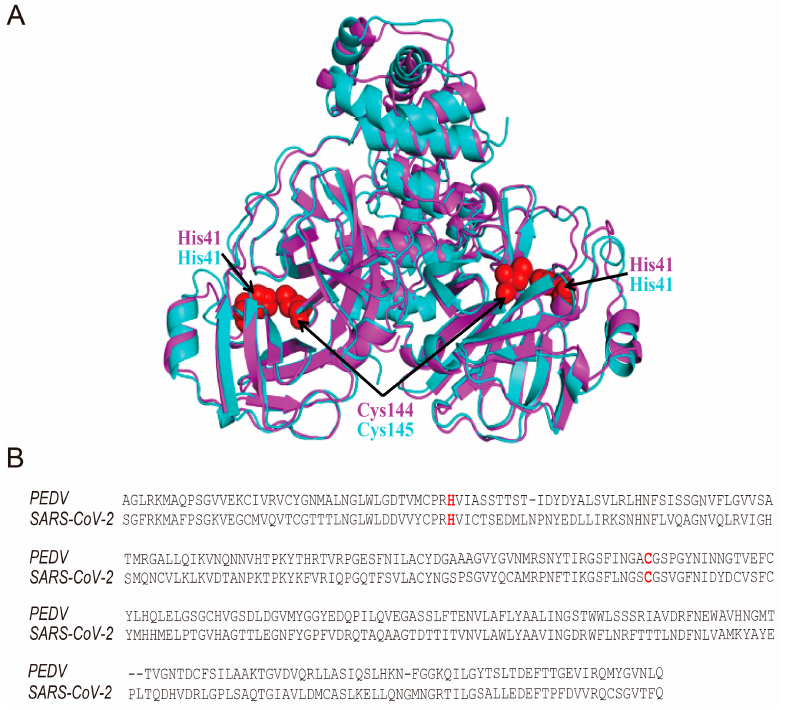
Figure 2. Alignments of PEDV and SARS-CoV-2 3CLpro in protein sequence and crystal structure. ( A ) The sequences of the PEDV 3CLpro (Accession number: MN644470.1) and SARS-CoV-2 3CLpro (Accession number: YP_009725295.1) are aligned by Clustal Omega tool (https://www.ebi.ac.uk/ Tools/msa/clustalo, accessed on 29 April 2021). The catalytic sites in SARS-CoV-2 3CLpro (His41 and Cys145) and PEDV (His41 and Cys144) are shown as red. ( B ) The crystal structures of PEDV 3CLpro (PDB: 4XFQ) and SARS-CoV-2 3CLpro (PDB: 6M2N) are aligned by PyMOL. PEDV 3CLpro is shown as pink cartoon, and SARS-CoV-2 3CLpro is shown as blue cartoon. The catalytic sites in SARS-CoV-2 3CLpro (His41 and Cys145) and PEDV (His41 and Cys144) are shown as red